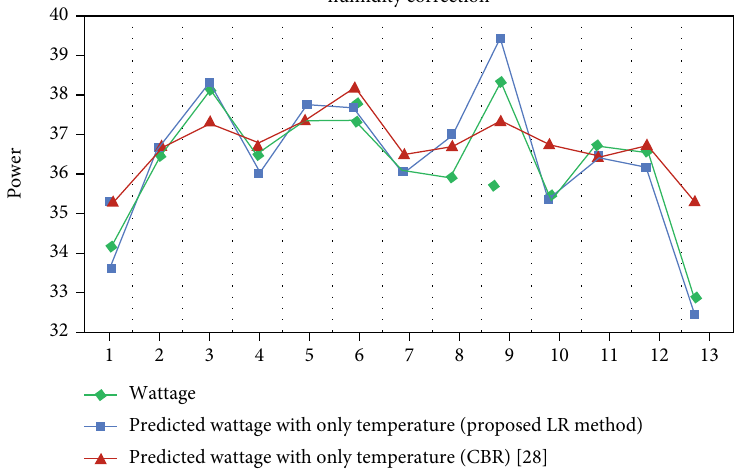
Figure 18: Comparison chart showing actual power and predicted power with humidity correction.